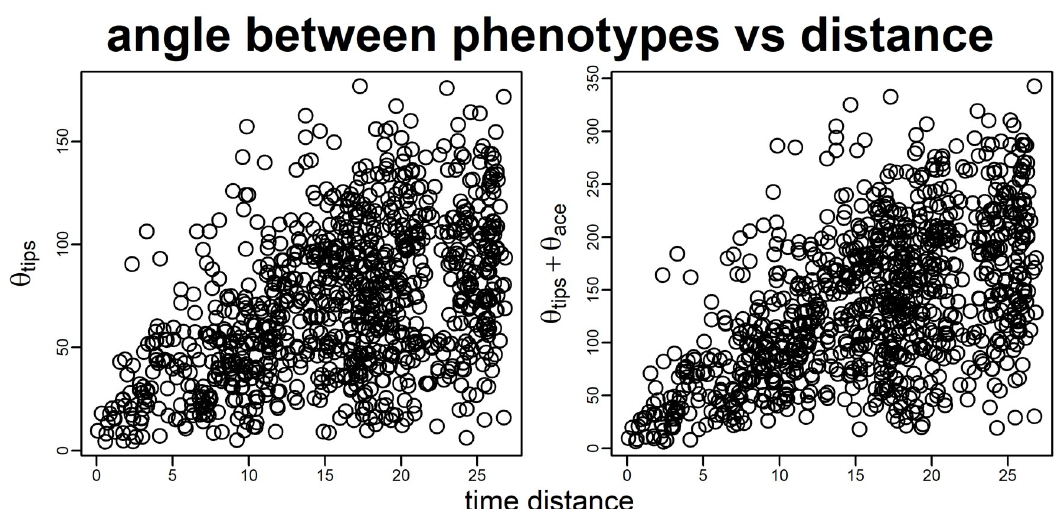
Fig 2. Plot of angles between phenotypic vectors versus time distance. The increase in the mean angle between the phenotypic vectors of all species pairs in the tree θ tips and the distance between the species (left). The sum of θ tips plus the angle between the phenotypes estimated at the first node above each tip θ ace plotted against the distance between these nodes (right). The phenotype was generated according to the Brownian Motion model of evolution with sigma2 (the Browian rate) = 1. The tree is 100 species